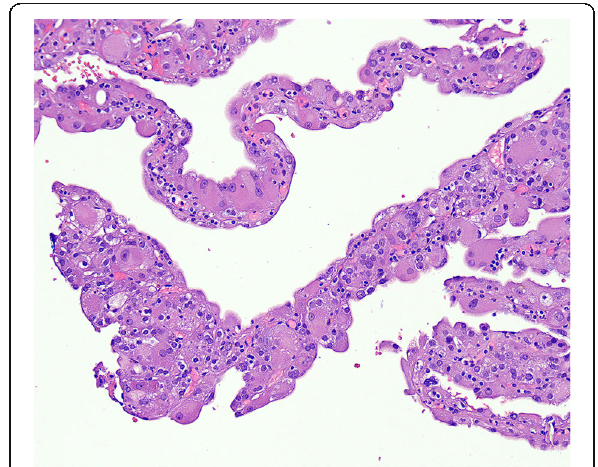
Fig. 3 Eosinophilic solid and cystic renal cell carcinoma. Cyst walls consist of typical tumor cells with voluminous granular eosinophilic cytoplasm. Smaller cells frequently show perinuclear